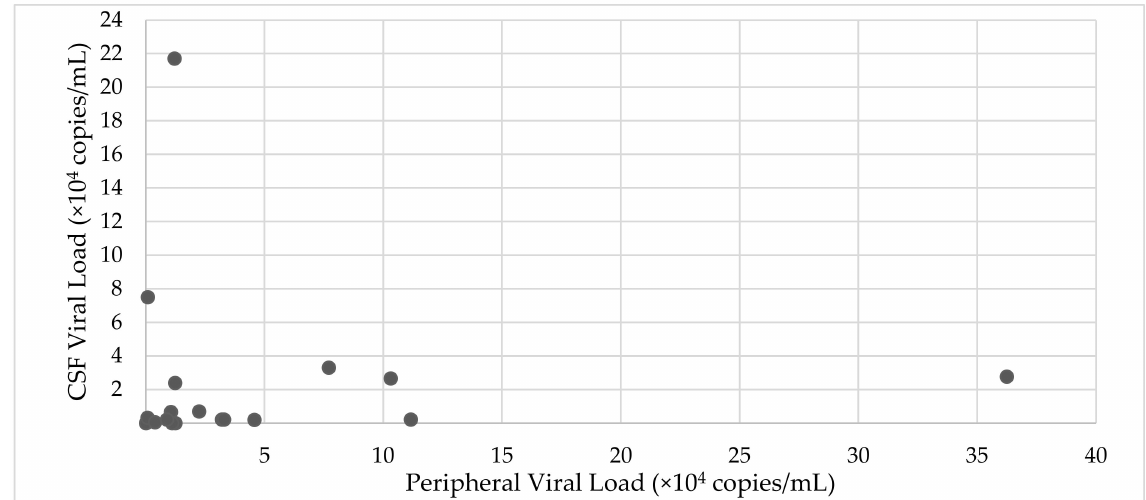
Figure 3. Relationship between CSF viral load and peripheral viral load ( n = 21).